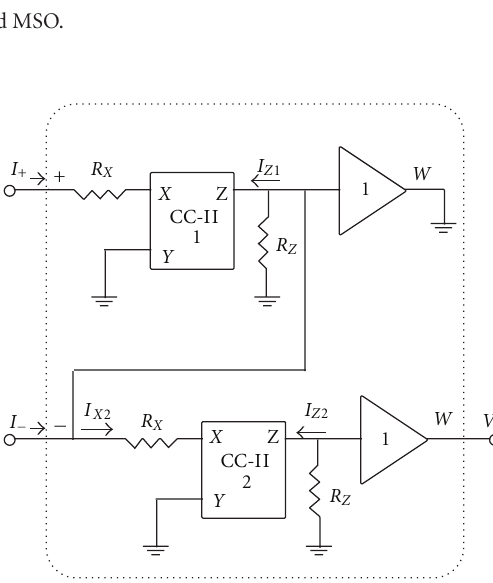
Figure 4: SRCO-based MSO.